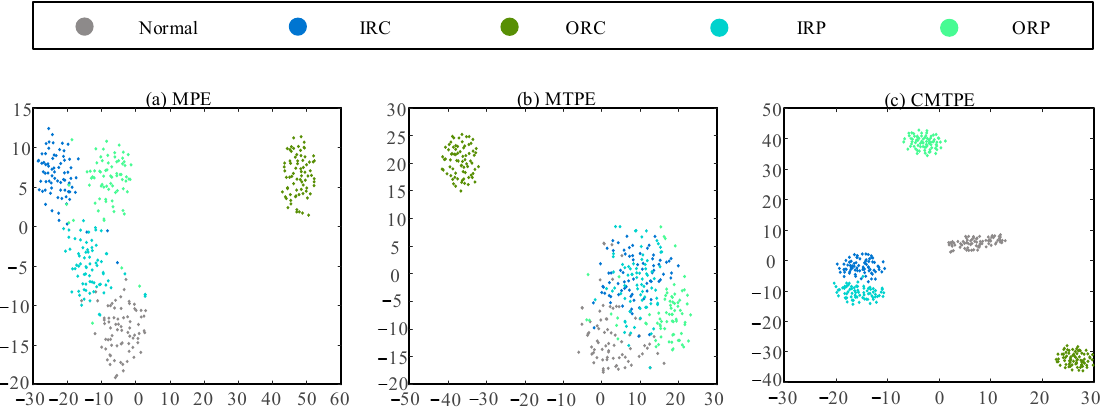
Figure 11. Effect of the number of training samples on the performance of CMTPE, MTPE, MPE and TPE.